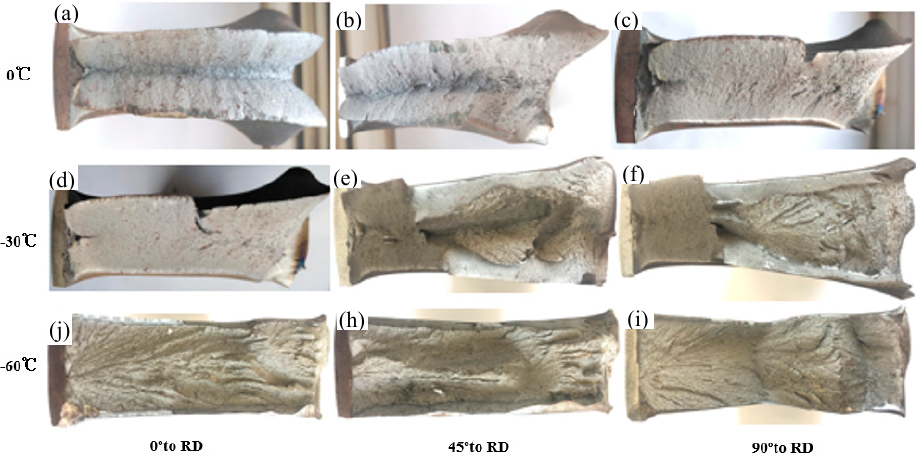
Figure 9. Selected fracture surfaces of the three directions (0° to RD, 45° to RD, and 90° to RD); DWTT specimens at three temperatures (0 °C, − 30 °C, and − 60 °C): ( a ) 0 °C and 0° to RD, ( b ) 0 °C and 45° to RD, ( c ) 0 °C and 90° to RD, ( d ) − 30 °C and 0° to RD, ( e ) − 30 °C and 45° to RD, ( f ) − 30 °C and 90° to RD, ( j ) − 60 °C and 0° to RD, ( h ) − 60 °C and 45° to RD, ( i ) − 60 °C and 90° to RD.